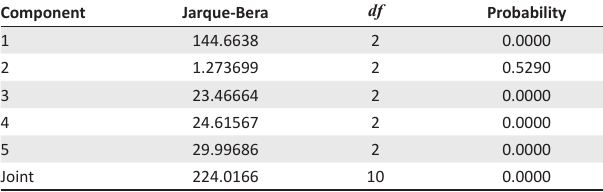
TABLE 6-A1: Vector autoregressive residual normality